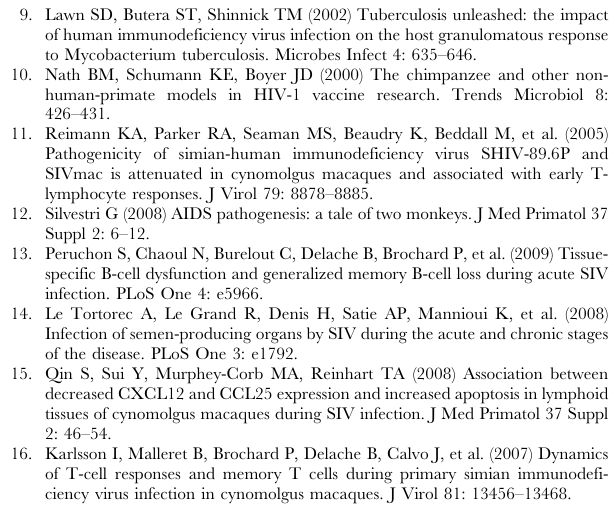
Figure S1 Schematic representation of experimental design.